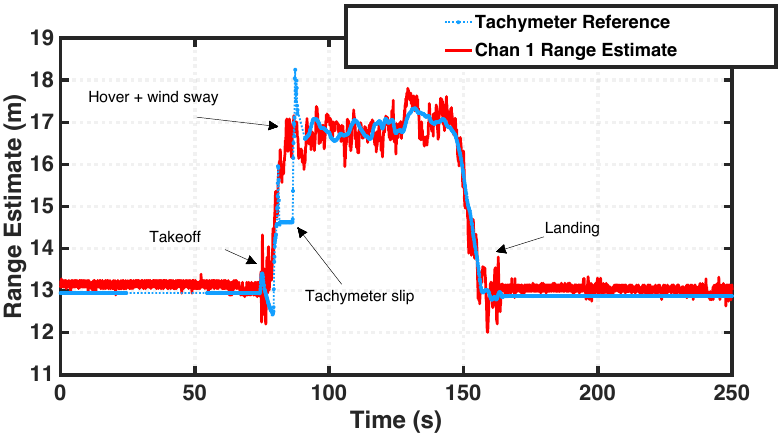
Figure 21. CHP2 range estimates (red) for a single transmit-receive antenna pair versus a tachymeter reference (blue) during a simple VTOL maneuver.